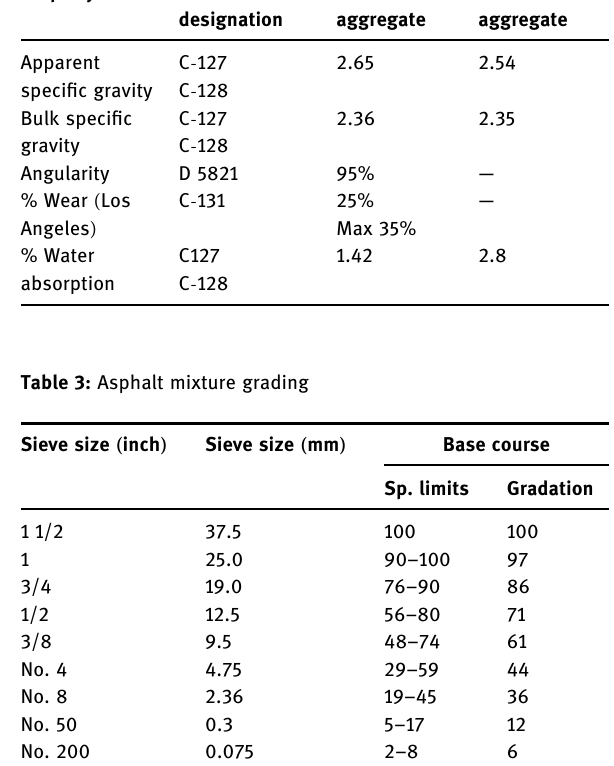
Table 2: Physical properties of the aggregate Property